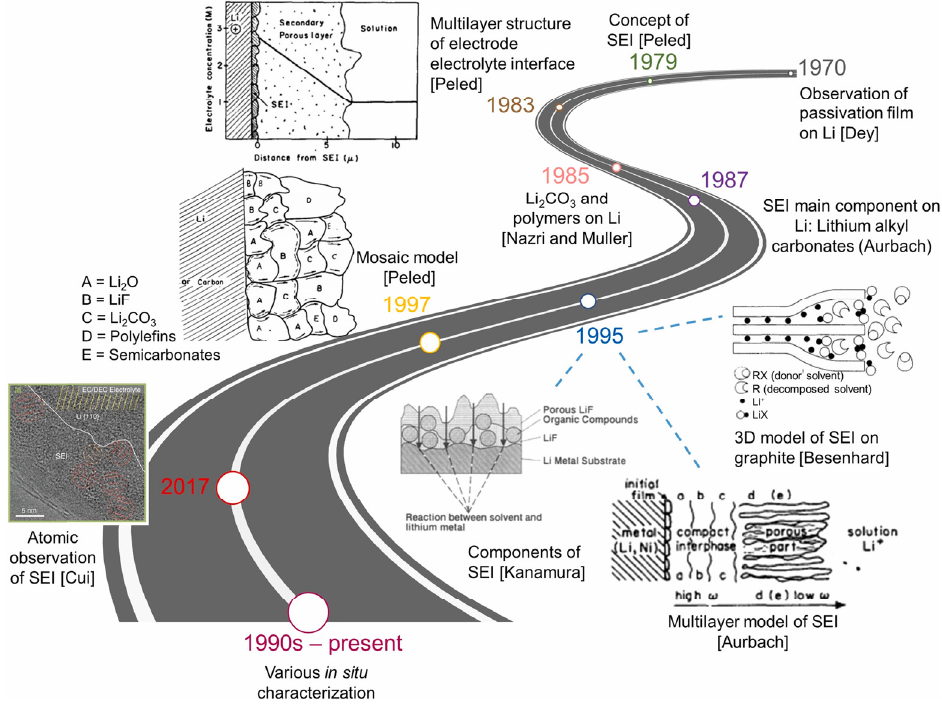
Figure 2. The historical timeline in explorations of SEI [26]. Copyright 2021, Elsevier.